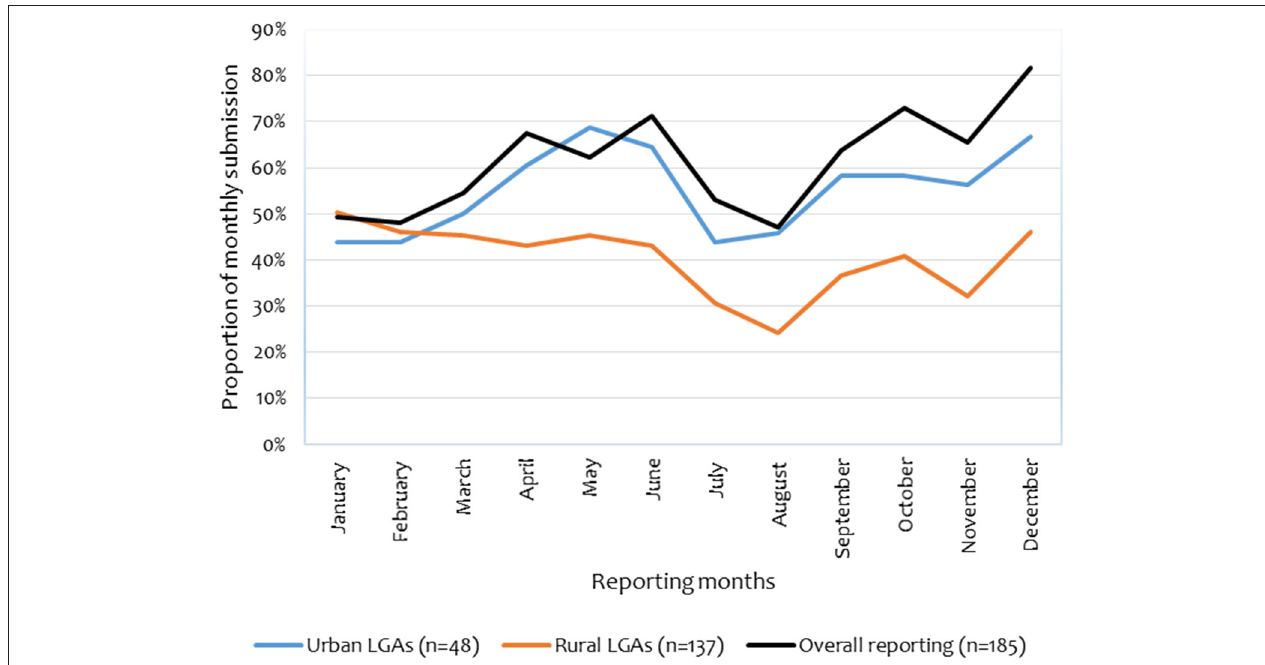
FIGURE 5 | Proportion of monthly reports received by the MoLF from LGAs throughout the